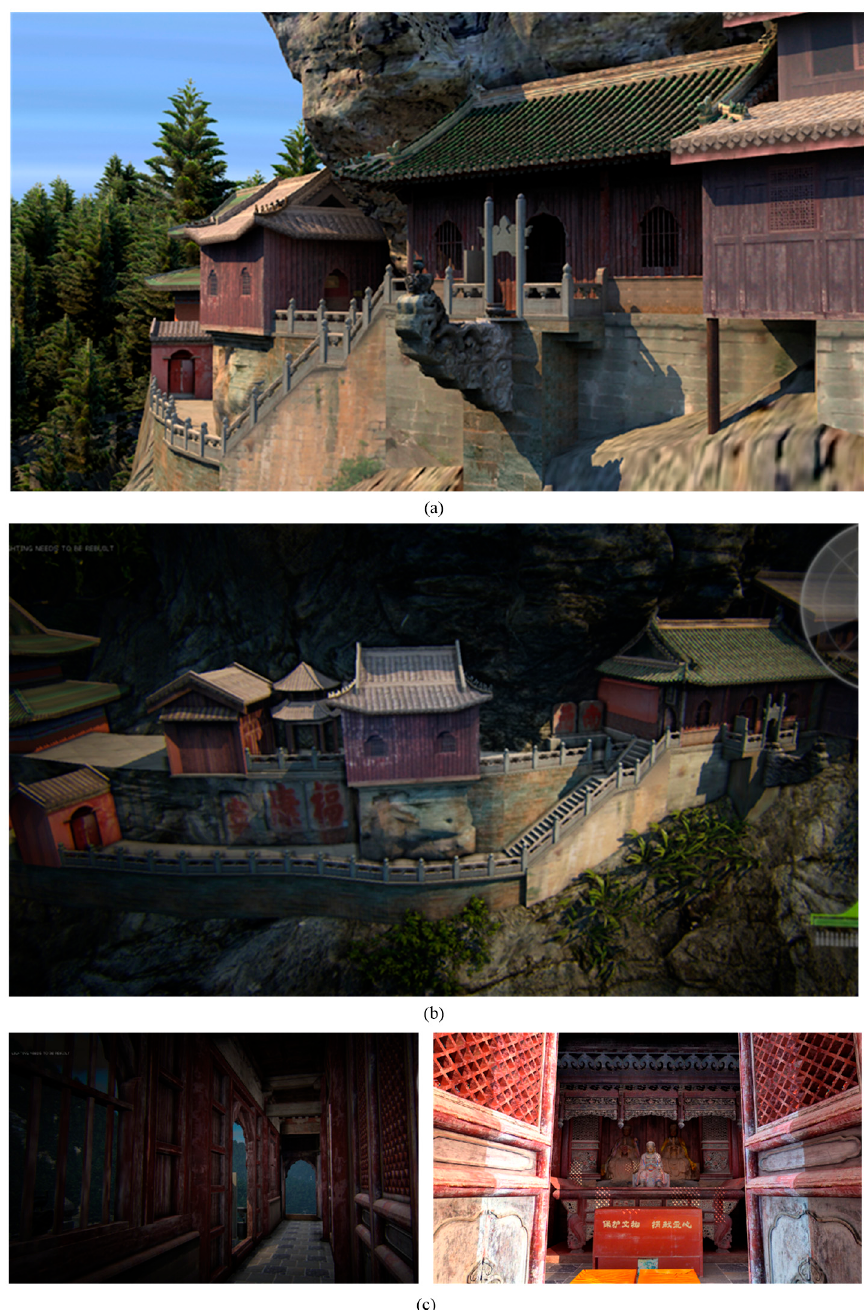
Figure 17. 3D scene of Liangyi Temple. ( a ) Front panoramic view; ( b ) top view; ( c ) inner view: corridor and